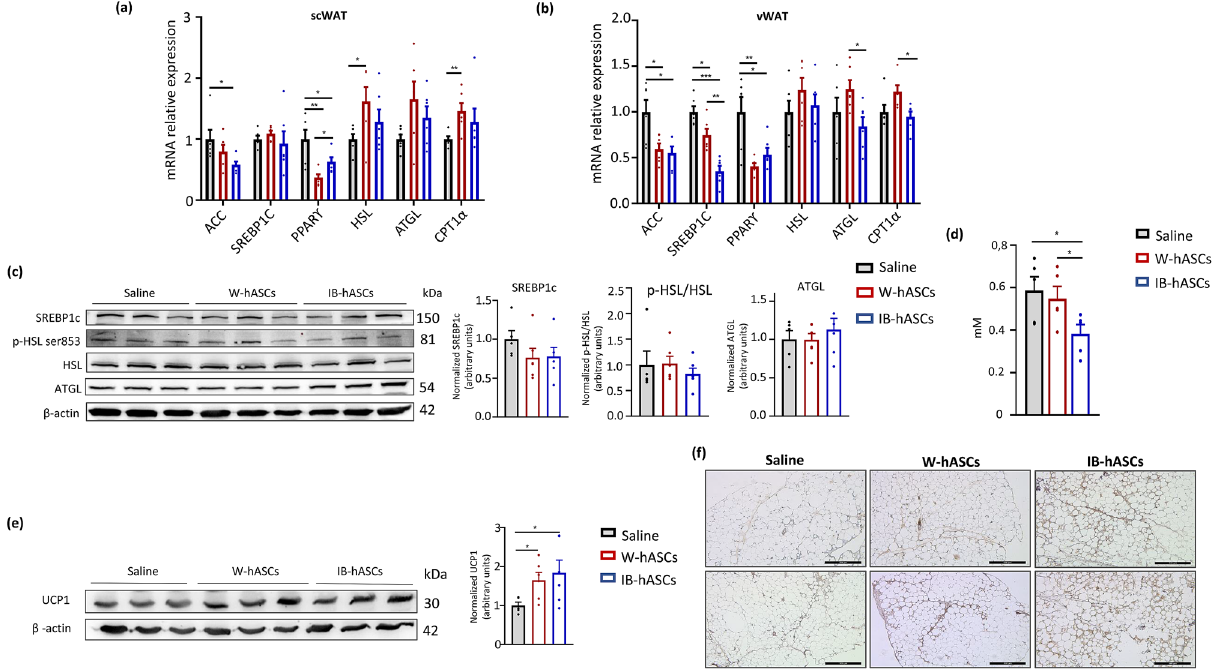
blot analysis for Ucp1 in vWAT. ( f ) Immunohistochemistry for Ucp1 in representative sections of vWAT. Scale bar = 500 µm. (n = 5–6 for saline and n = 6 for W-hASCs and IB-hASCs). Data are shown as mean ±